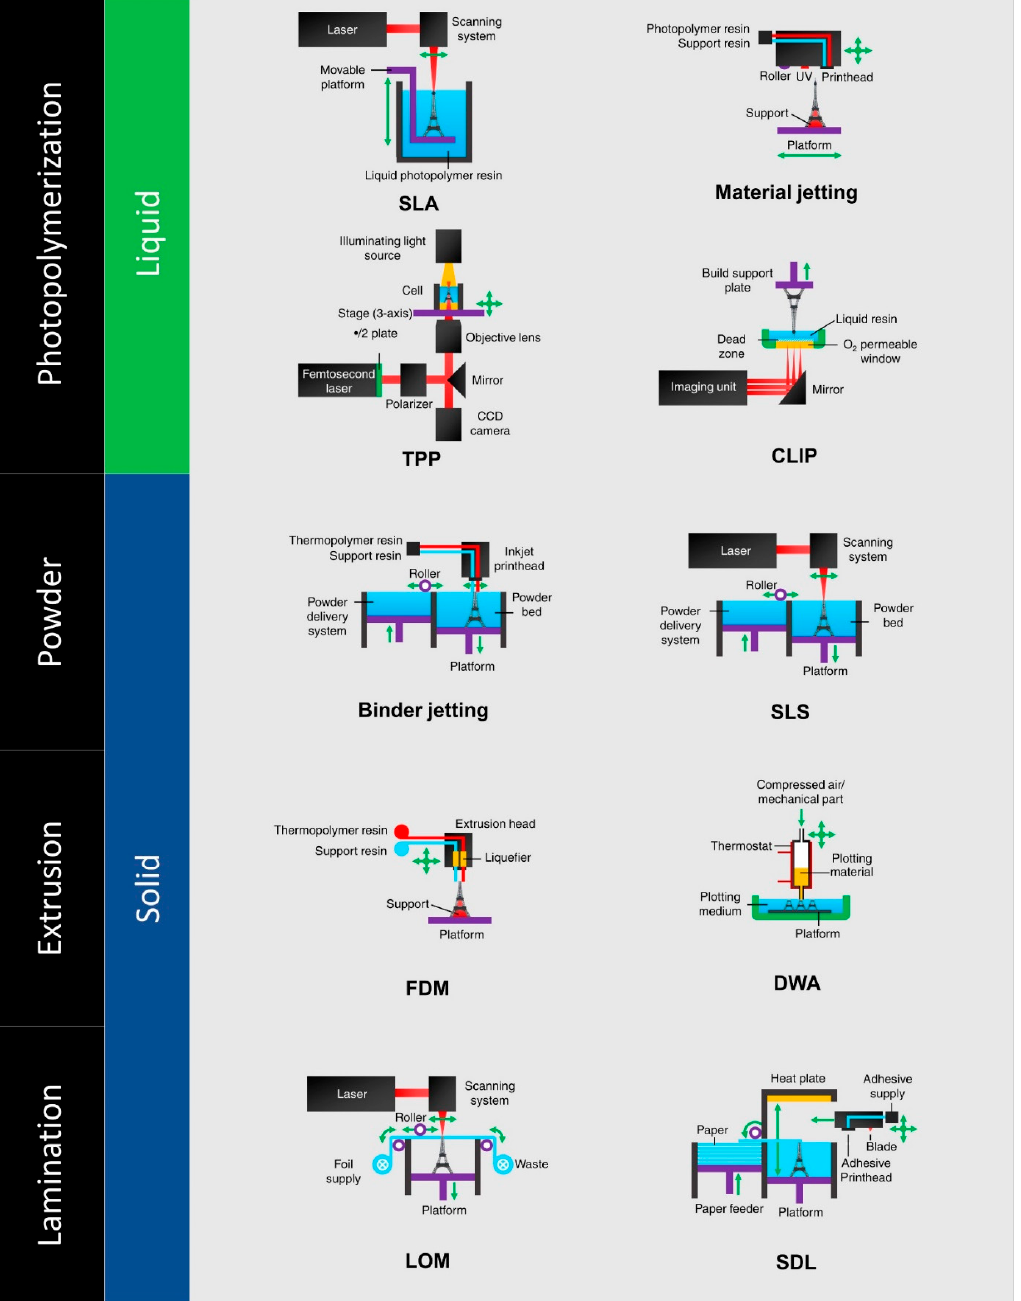
Figure 3. Types of 3D printers (adapted with permission from reference [20]).